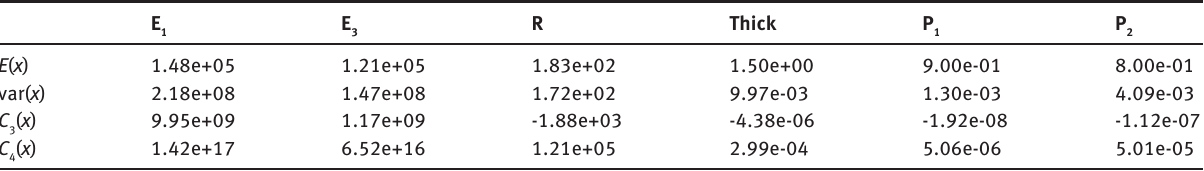
Table 3 First four central moment of the random variables.